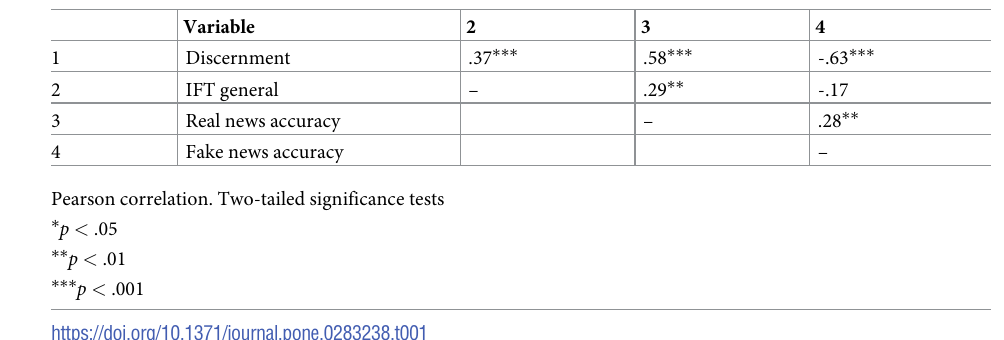
Table 1. Zero-order correlations between